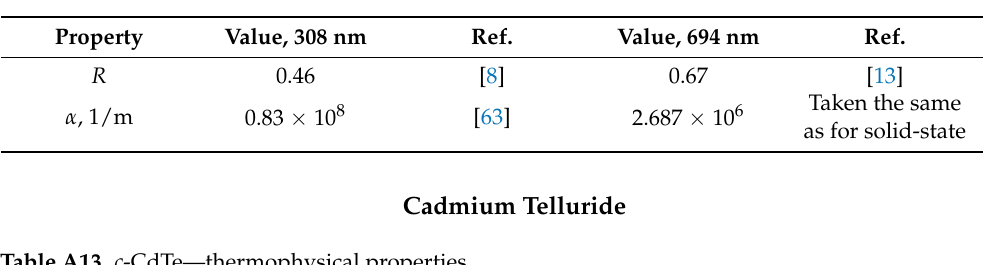
Table A12. Liquid -GaAs—optical properties.